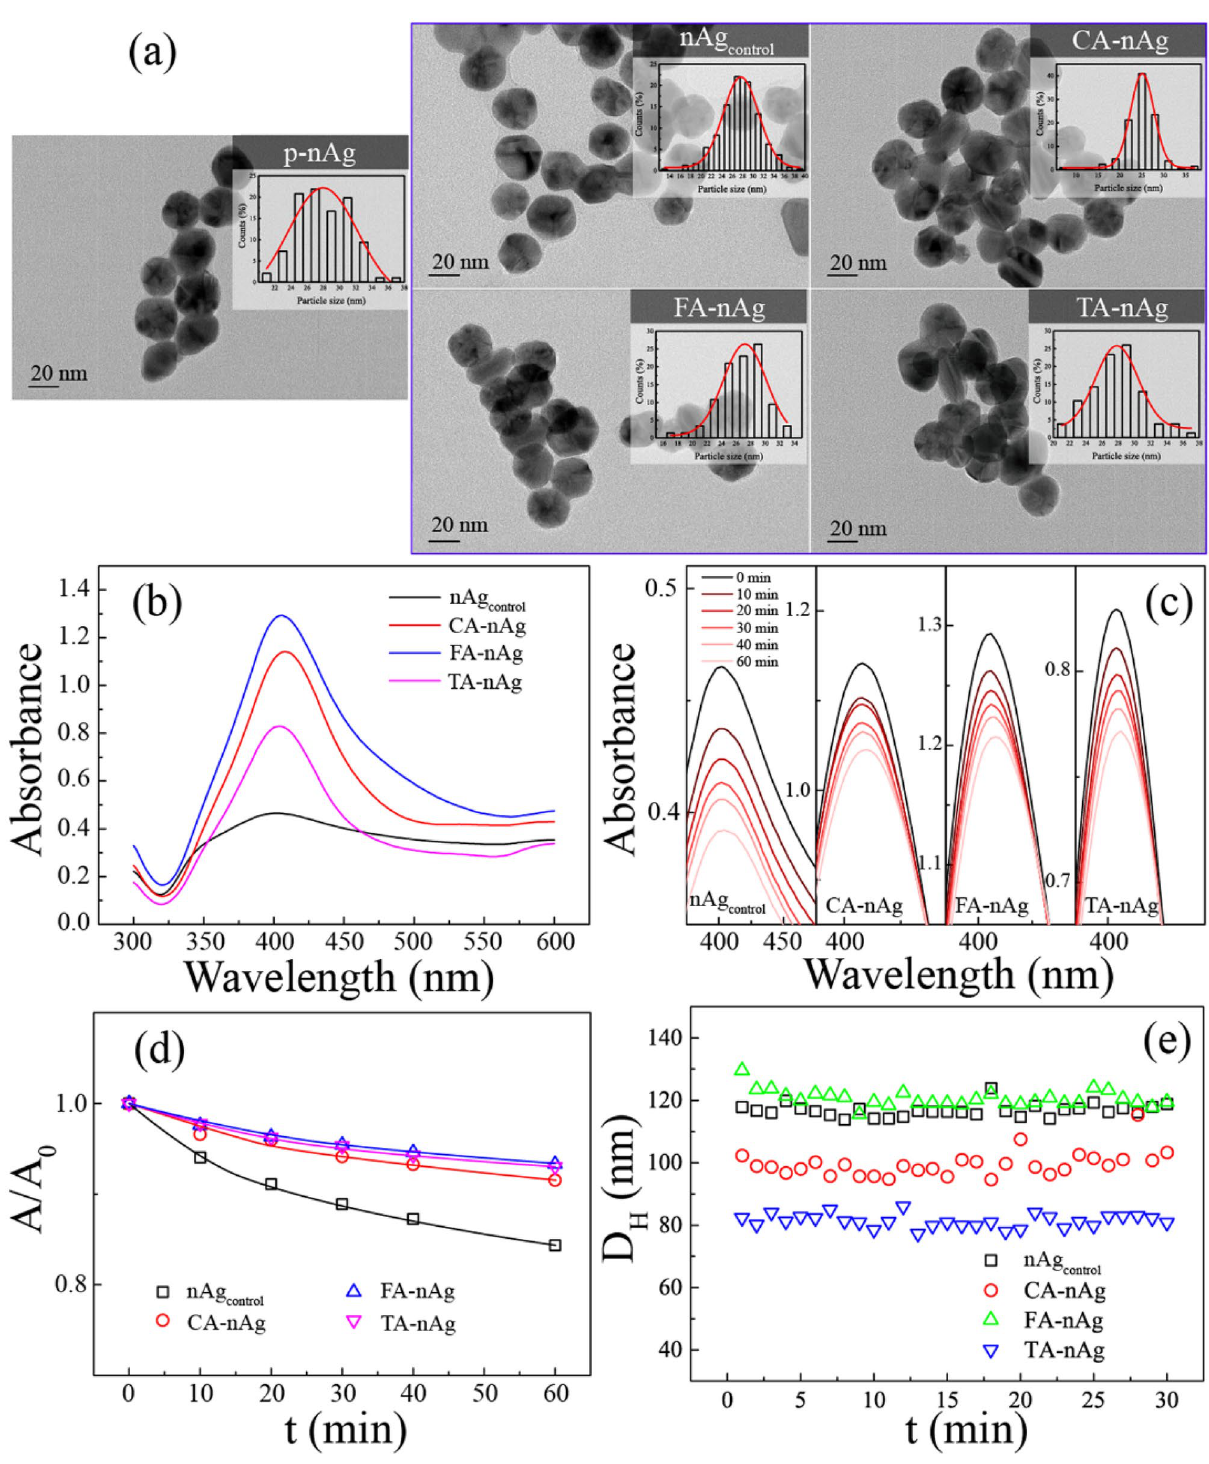
Figure 1. TEM characterizations of AgNPs and stability of AgNPs suspension in CM (20 μg ml −1 at 37 °C). ( a ) Size distribution of pristine nAg (p-nAg), nAg control , CA-nAg, FA-nAg and TA-nAg characterized by TEM at least 200 particles. ( b ) UV–Vis absorption spectrum of nAg control , CA-nAg, FA-nAg and TA-nAg suspension. ( c ) UV–Vis spectra over 60 min. ( d ) The ratios of the absorbance to the initial absorbance at λ max over 60 min fitted with first order removal model. ( e ) Hydrodynamic diameters of AgNPs suspension over 30 min by